Question: Write the caption for this figure.
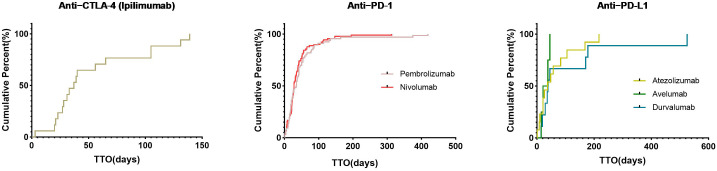
Answer: Number of reports and onset time of neuro-ophthalmic irAEs associated with different types of ICIs